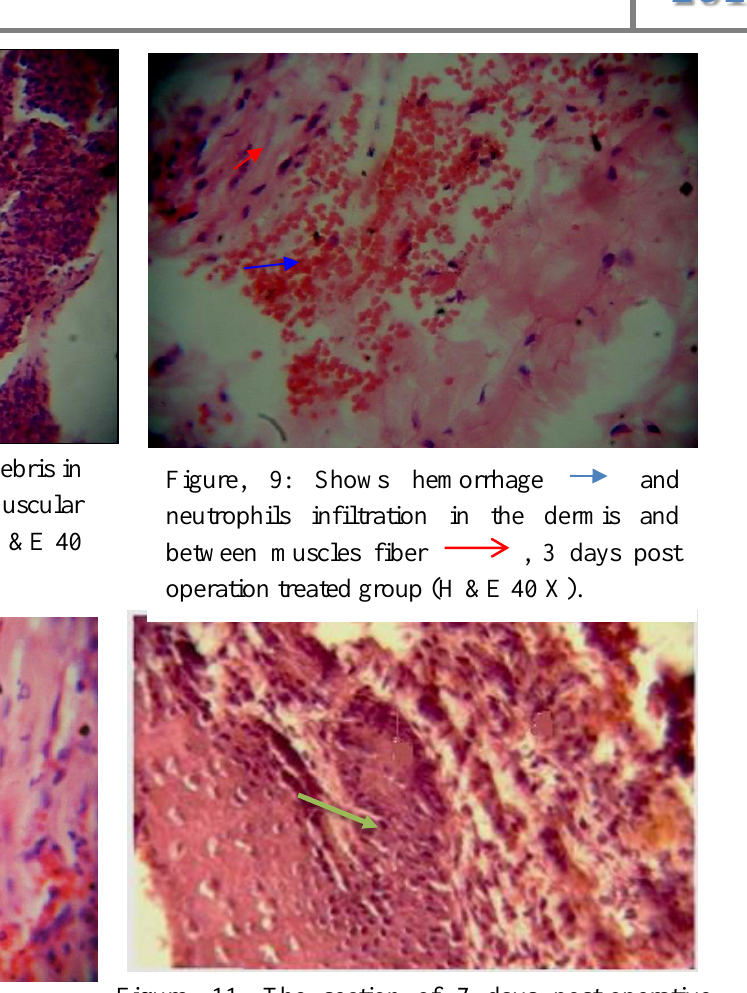
Figure, 11: The section of 7 days post-operative, treated group there is fibrous connective tissue proliferation which characterized by more collagen , 5 days post deposition, moderate irregular direction and sever thickness of epidermis; formed papillae extended to the dermis (H&E 40 X).